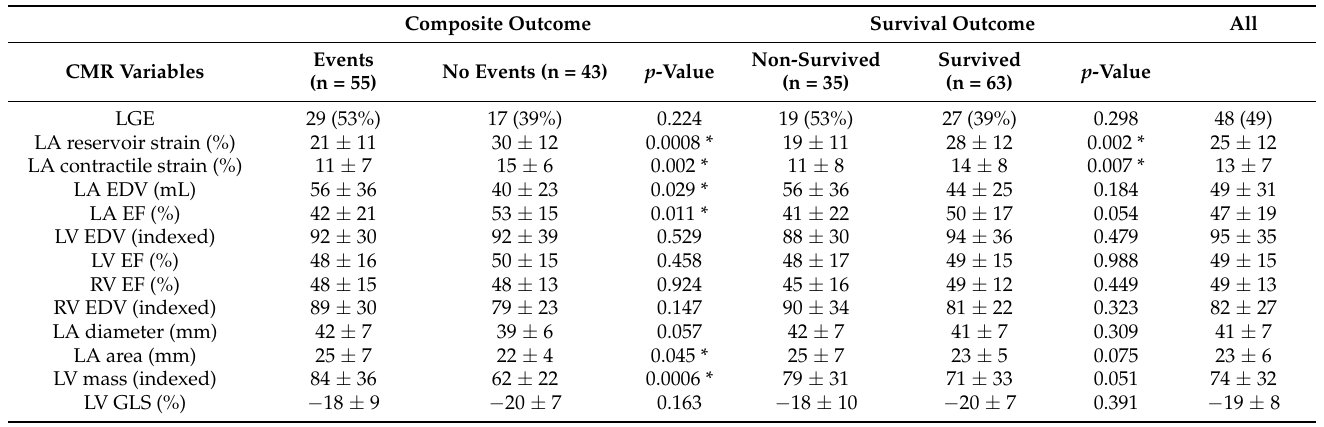
Table 2. Imaging characteristics stratified by the two endpoints: time to composite events and